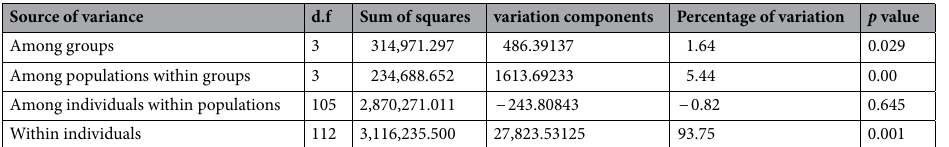
Table 3. Hierarchical analysis of variance based on pairwise differences*. *Significance tests based on 1023 permutations.